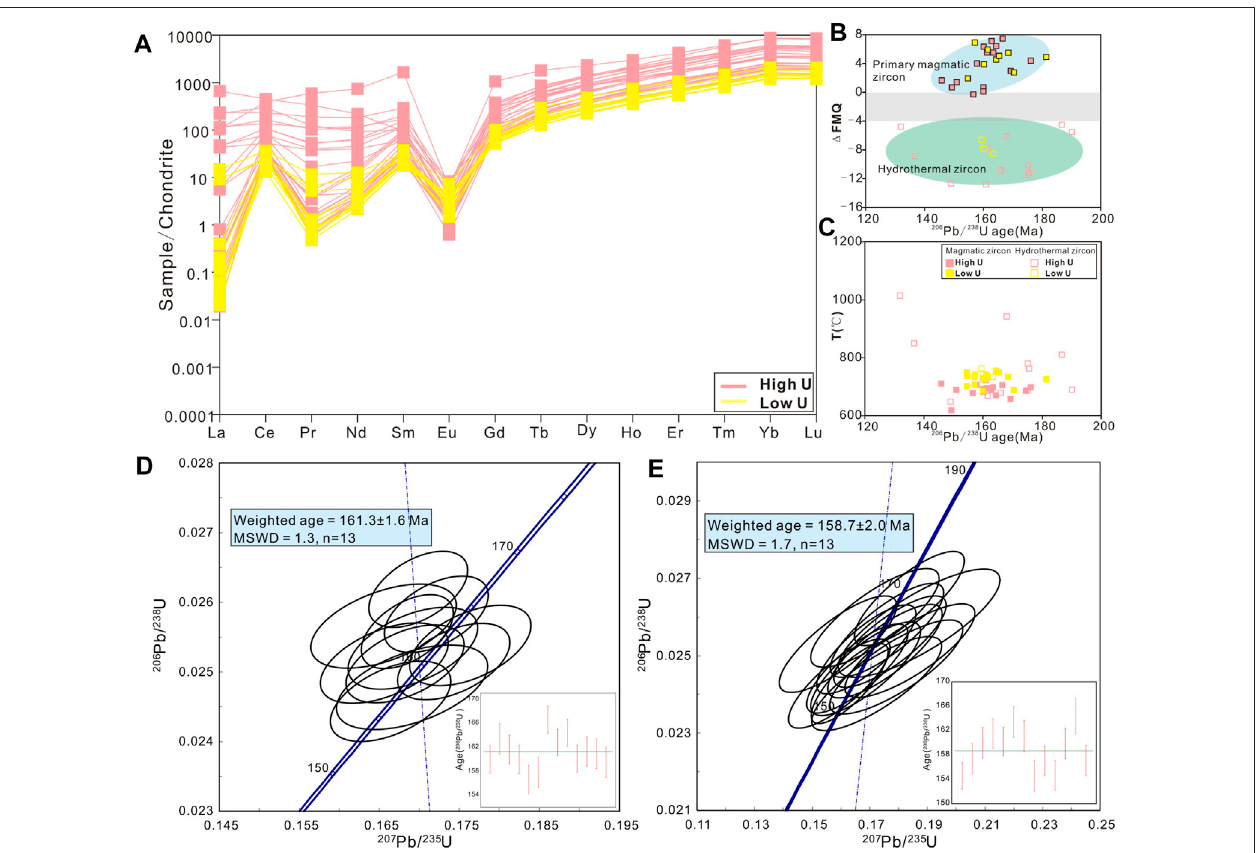
FIGURE 8 | (A) Chondrite-normalized REE patterns of different zircon groups in the Jianfengling porphyritic biotite monzogranite. Chondrite-normalized values from Taylor and McLennan (1985); (B) Δ FMQ vs 206 Pb/ 238 U age. Zircon oxygen fugacity was calculated from the method by Ballard et al. (2002); (C) Ti-in-zircon temperature vs 206 Pb/ 238 U age. The temperature was obtained with the method by Ferry and Watson (2007) (D,E) U – Pb concordant plots of different zircon groups in the porphyritic biotite monzogranite.